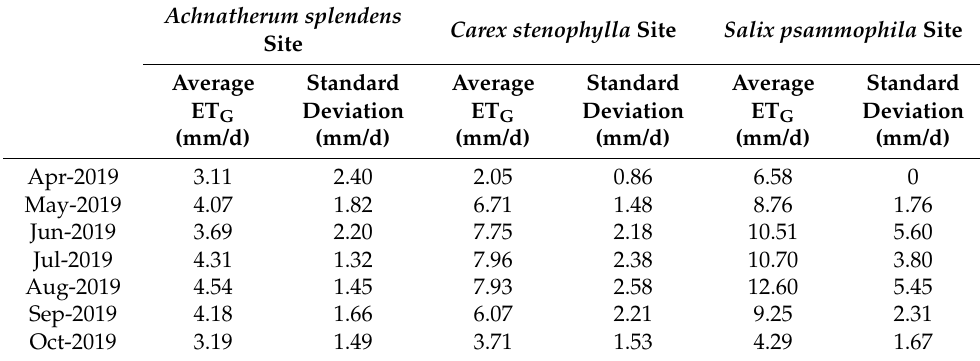
Table 5. The average groundwater evapotranspiration (ET G ) and standard deviation at monthly scale for various vegetation